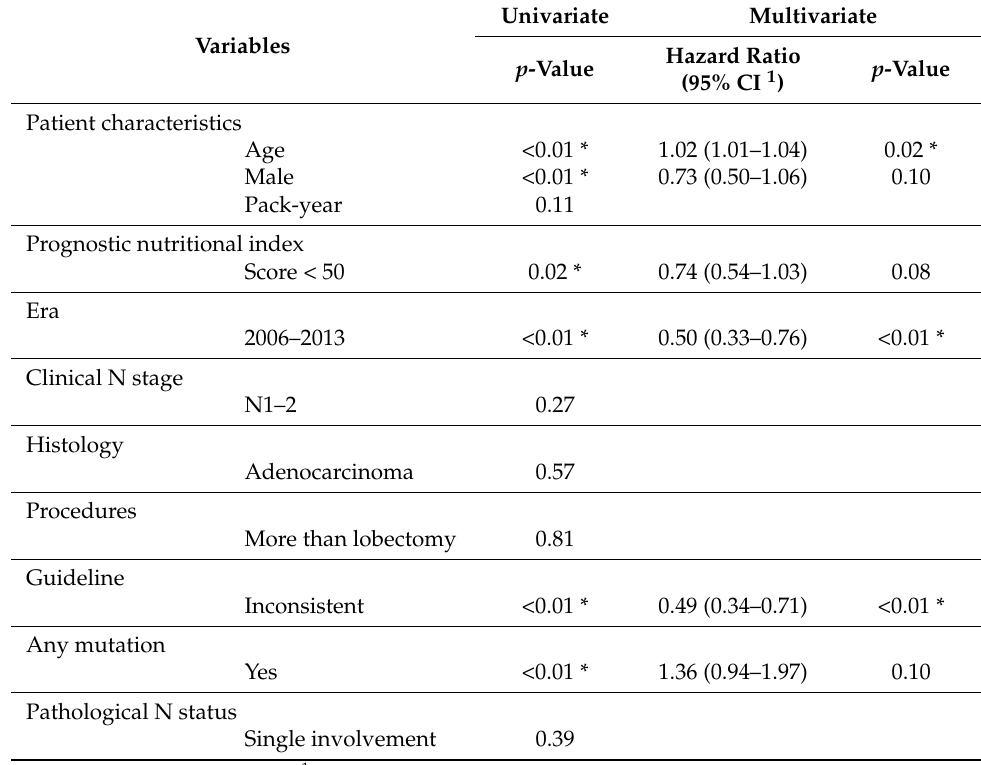
Table 2. Univariate and multivariate analyses of overall survival.